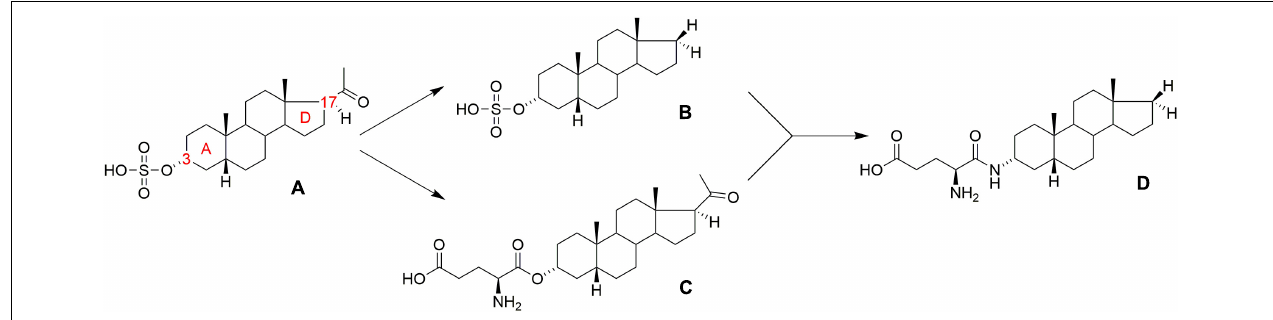
FIGURE 1 | Structure of (A) pregnanolone sulfate (PAS), (B) androstane 3-sulfate, (C) pregnanolone 3-glutamate (PAG), and (D) PAG-like compound.